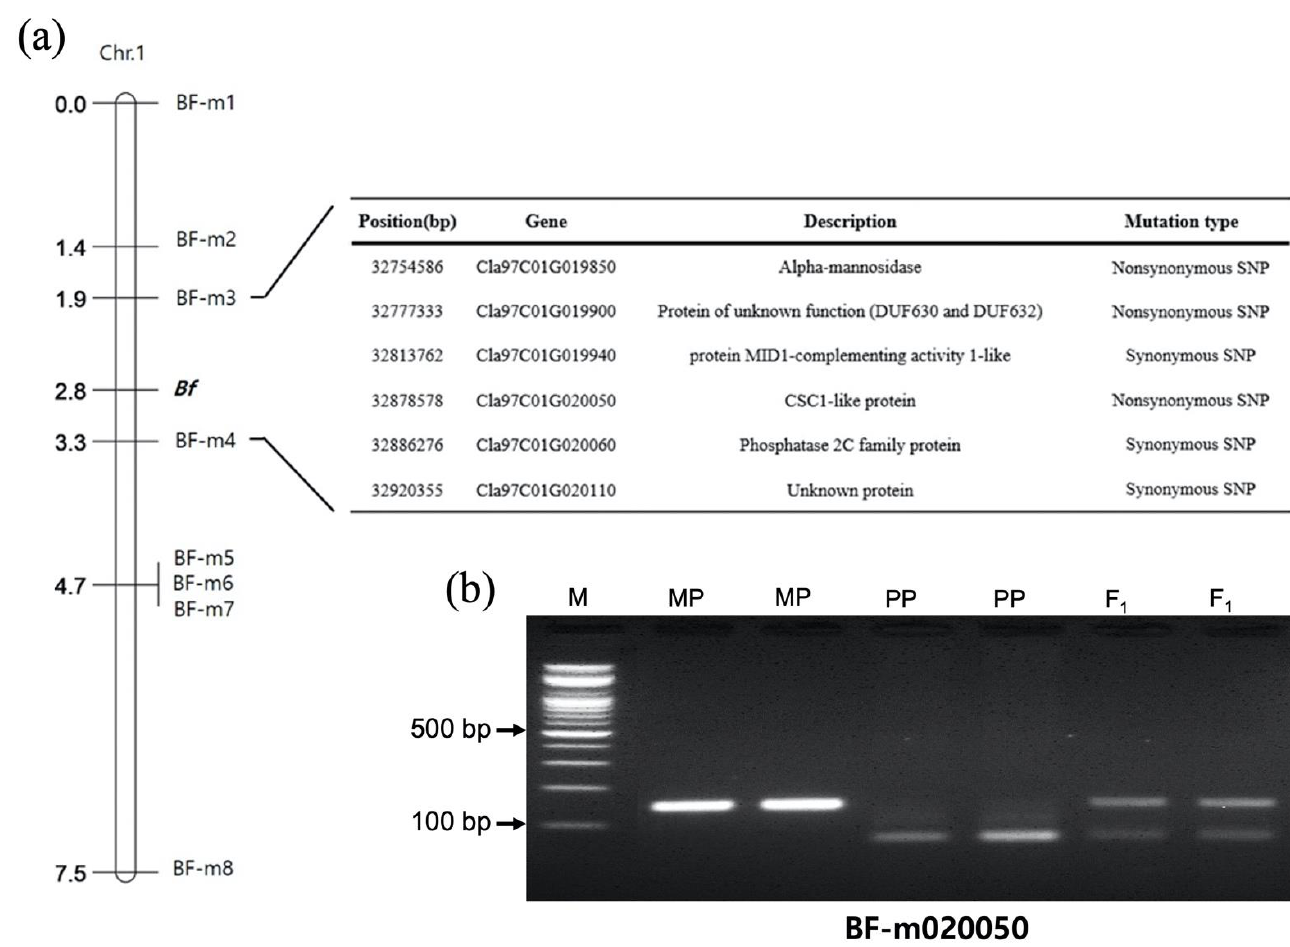
Figure 4. ( a ) A genetic linkage map showing the location of the locus ( Bf ) for bloom formation and gene annotation information and SNPs in coding sequences between the two cleaved amplified polymorphic sequence (CAPS) markers (BF-m3 and BF-m4) flanking Bf . ( b ) From the three nonsynonymous SNPs, two CAPS markers BF-m019900 and BF-m020050 were developed for SNPs located on genes Cla97C01G019900 and Cla97C01G020050 and used to genotype the 219 F 2 plant SNPs. BF-m020050 cosegregated with Bf in this F 2 population.